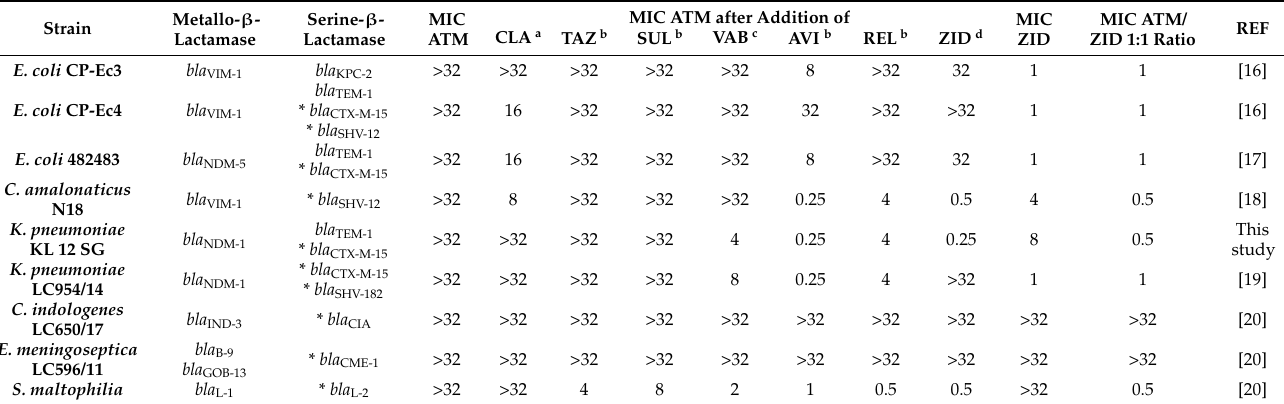
Table 1. MIC ( µ g/mL) of aztreonam, alone and in association with BLIs, of tested